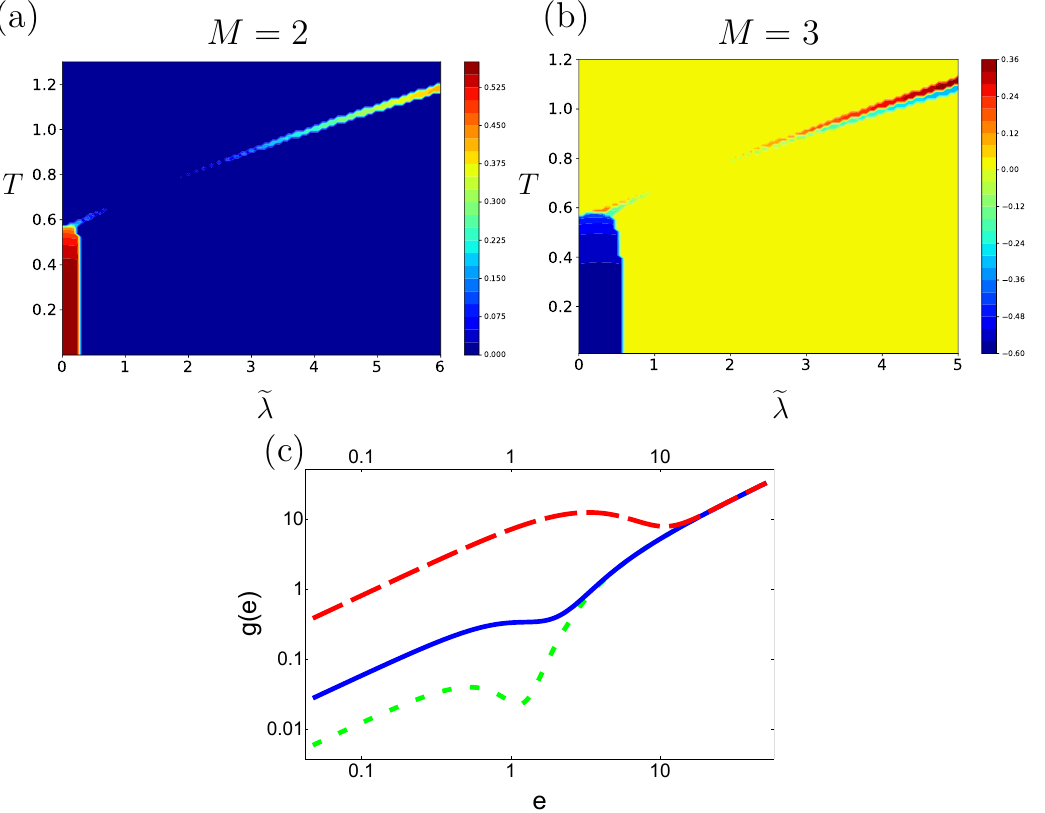
Figure 9 . (a) The phase diagram for M = 2 (a) and M = 3 (b) at µ = 0 with g 1 = 1 and g 2 = 3 . 75 e e in the large- N limit. The magnitude of | e 1 − e 2 | is plotted. The strip of first order transitions for high temperature is interrupted roughly between e λ = 1 and e λ = 2 , but is present close to the broken phase around the origin and at high temperatures. In figures (c) we show a log-log-plot of the function g ( e ) where γ 2 = 3 π/ (2 g 2 ) ≈ 0 . 34 for three different temperatures T = 0 . 59 (green e dashed curve), T = 0 . 7 (blue solid curve), and T = 2 . 5 (red dashed curve). The remnant of the strip close to the bulk of phase transitions at the origin can be explained by the existence of a “wiggle” of g ( e ) which briefly dissolves for larger temperature and reappears anew. For smaller g 2 e (larger γ 2 ) the high temperature strip of phase transitions is completely separated from the broken phase near the origin, cf. figures 7 and